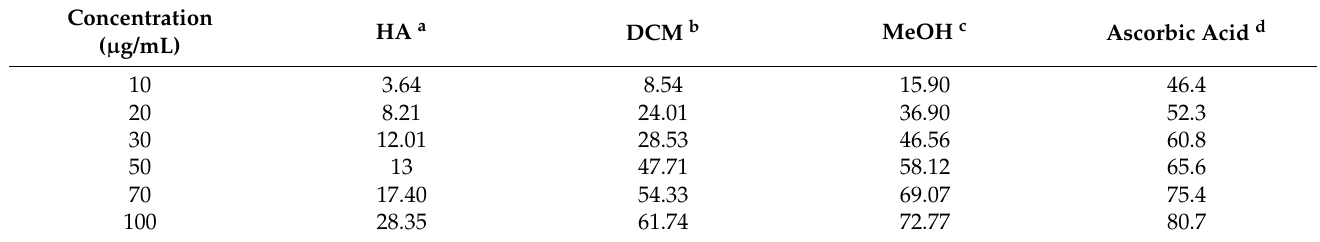
Table 5. %RSA via DPPH of N. mexicana Zucc. extracts.